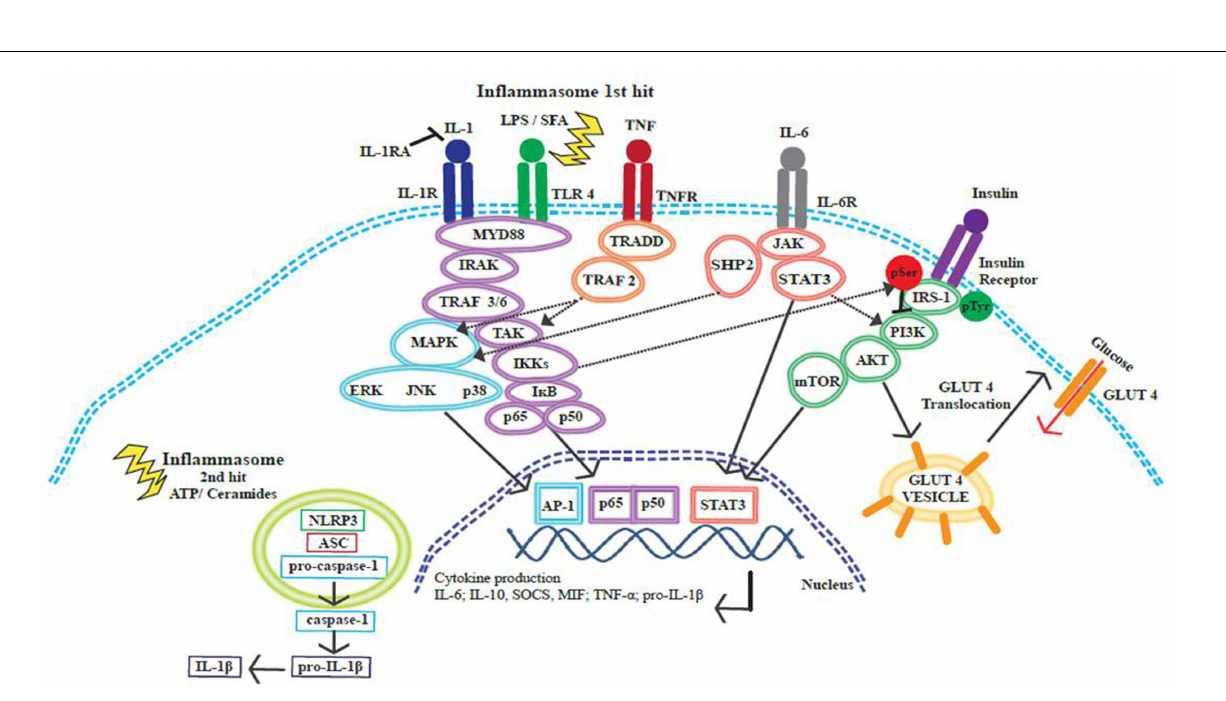
FIGURE 4 | Cross-talk between insulin and inflammatory signaling pathways . Inflammatory signaling pathways activated by SFA or by pro-inflammatory cytokines IL-1 β , IL-6, andTNF- α initiate a cascade of events that promote the release of further inflammatory mediators.These signaling events converge at the NF- κ B and MAPK pathways, resulting in the translocation of transcription factors to the nucleus, transcriptional activation, and cytokine production.The inflammasome is activated through a two-hit process; with obesity the first hit occurs whenTLR4 is activated by SFAs and this results in pro-IL-1 β production, ATP or ceramides then provide the second